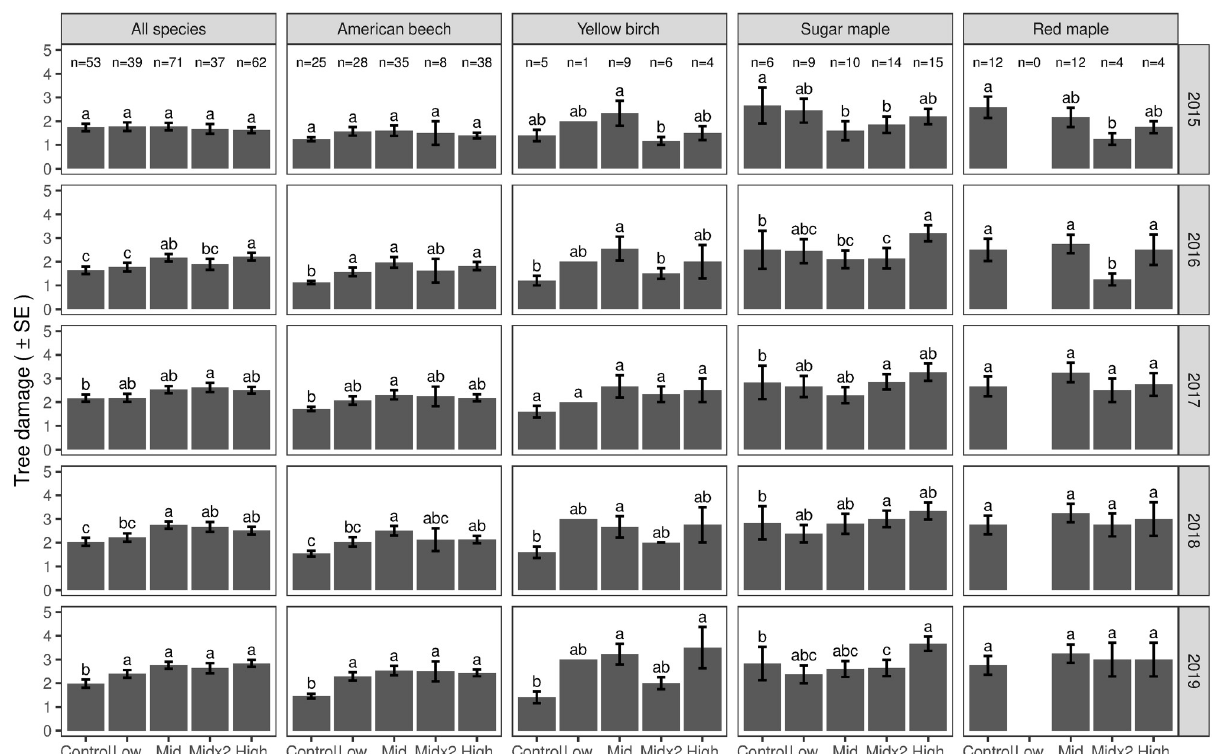
Fig 7. Tree canopy damage assessments among treatments grouped by year. Different letters denote significant differences among treatments ( P < 0.05) within a sampling period. Vertical lines are 1 standard error.